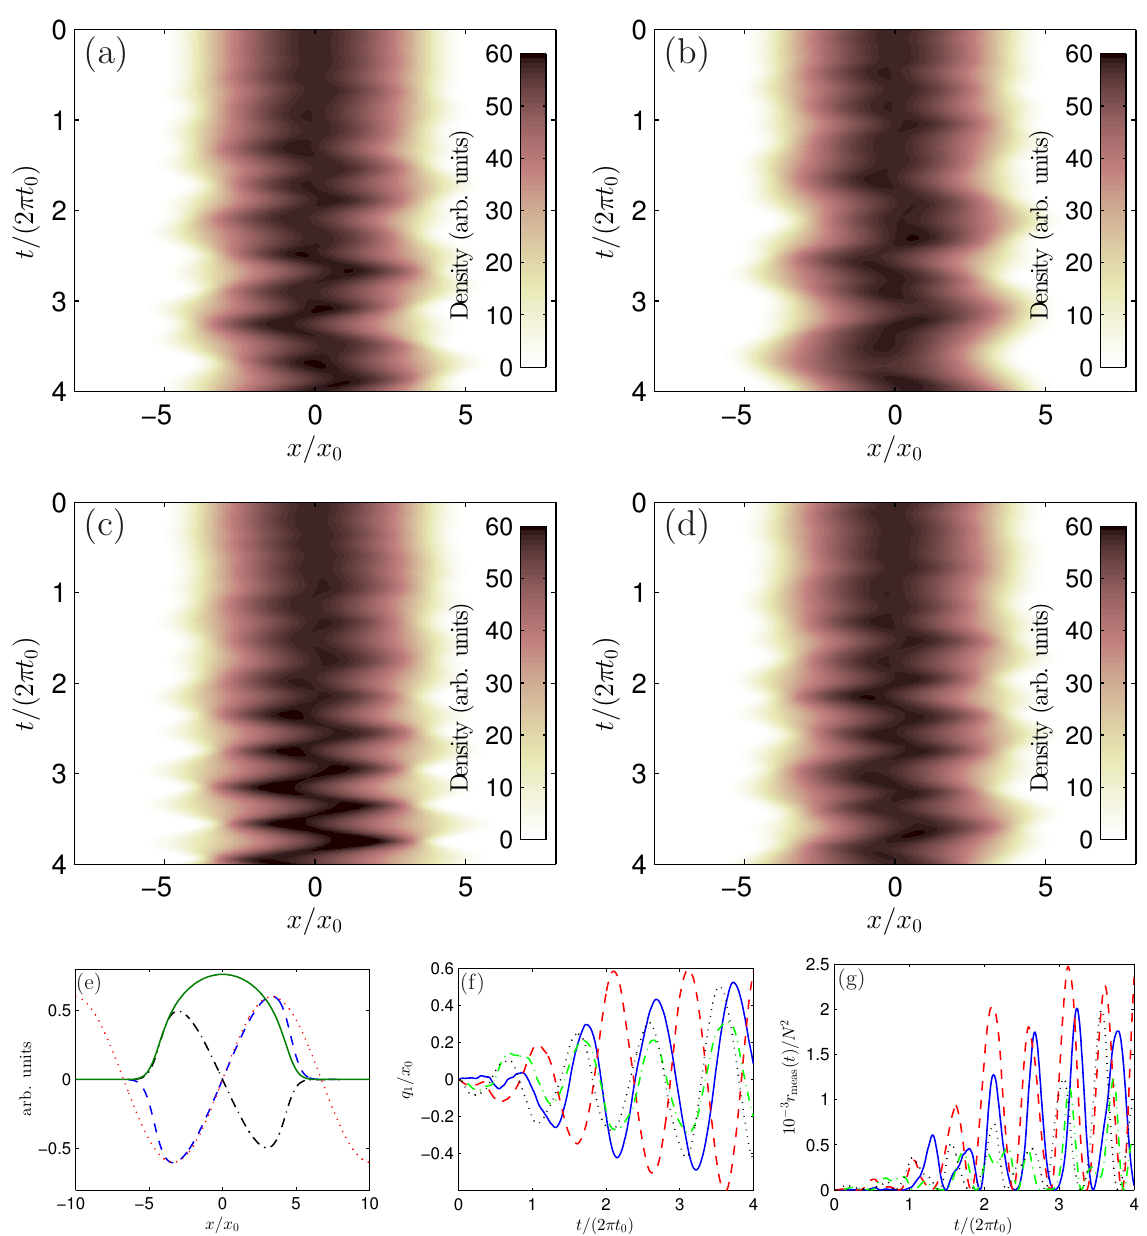
Figure 2. A selective excitation of collective modes of a BEC as a result of quantum measurement backaction. ( a – d ) The stochastic field density | ψ ( x, t ) | 2 as a function of time for four different single realizations of measurement trajectories in which the Kohn mode is excited. The transverse pump beam is applied at t = 0 and remains at a constant strength throughout the simulation. ( e ) Comparison of the shapes of the Kohn mode quasiparticle functions u ( x ) (blue, dashed) and v ( x ) (black, dashed) with the cavity mode 1 1 function g ( x ) (red, dotted), and the initial stochastic field for the condensate ψ ( x ) (green, solid), for the case where the overlap of the cavity mode and the Kohn mode is maximal. Subfigure ( e ) reproduced from [15]. The differing quantities have been scaled into arbitrary units to enable a comparison of their functional form. ( f – g ) The center-of-mass position (cid:82) q x | ψ ( x, t ) | 2 dx and measurement rate of photons r ( t ) = ( t ) corresponding to the 1 meas single realizations illustrated in ( a ) (blue, solid), ( b ) (red, dashed), ( c ) (green, dot-dashed) and ( d ) (black,